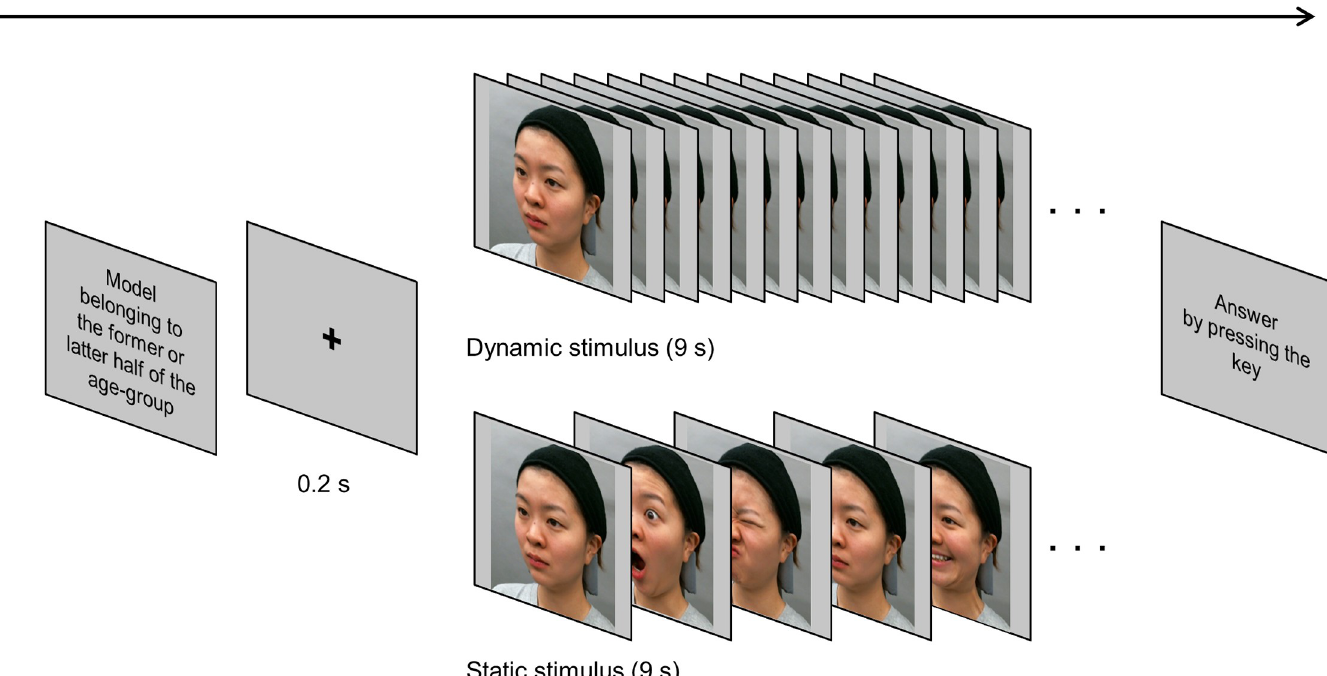
Fig 5. An example of the procedure of the age-cognitive experiment. After looking at the introduction part of the movie, the observers were asked to fix their gazes at a center point on a liquid-crystal display (LCD) for 0.2 s, observe the dynamic stimulus or static stimulus for 9 s, and answer to which half of the age group, the former or latter half, the model belonged by pressing a